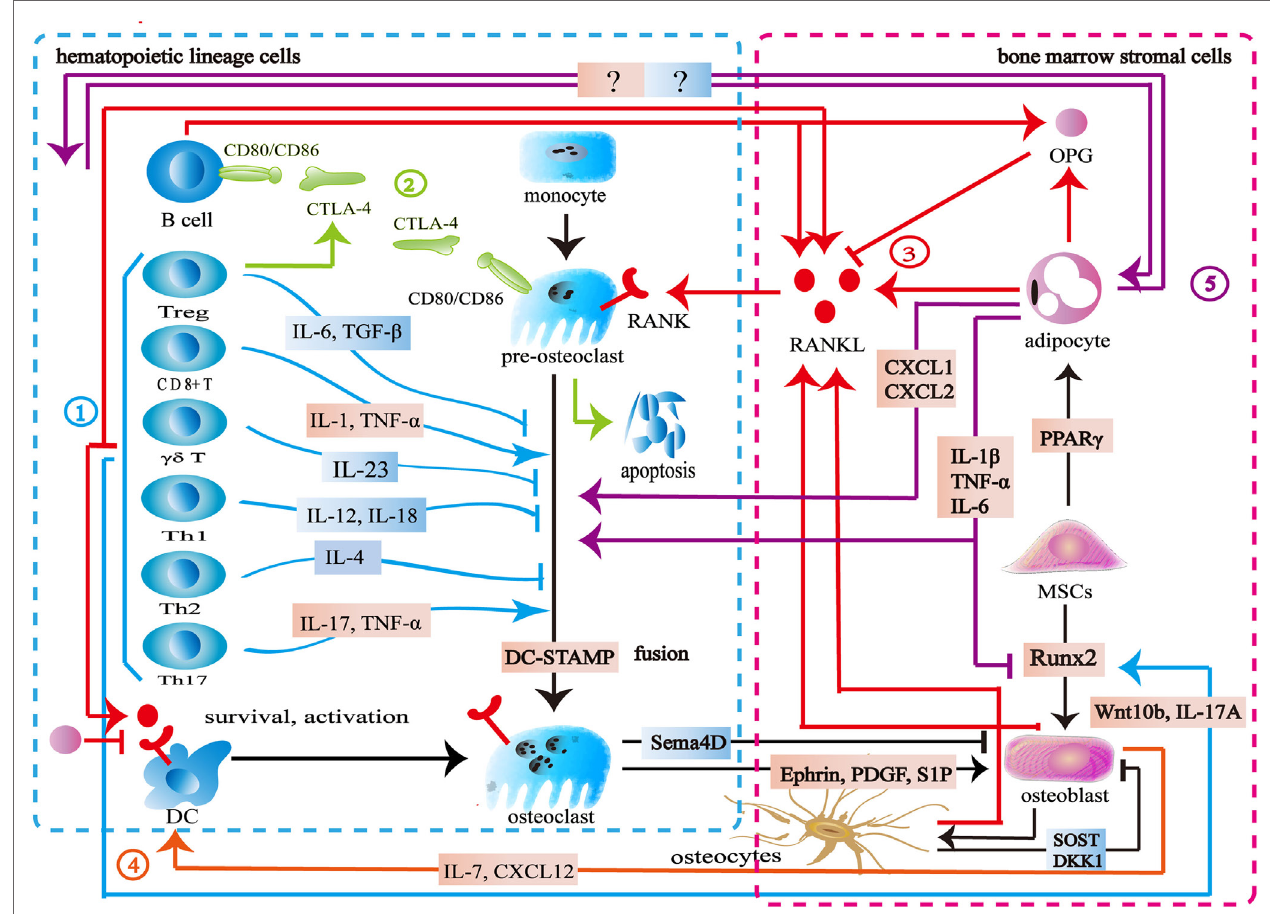
FiGURe 1 | Interaction between the skeletal and immune systems. ① The immune cells produce various cytokines and molecules to regulate bone cells. IL-23, IL-6, IL-12, IL-18, IL-4, interferon-gamma (IFN- γ ), TGF- β , and OPG inhibit osteoclastogenesis, while IL-1, IL-6, IL-17, TNF- α , TNF- β , RANKL, and macrophage colony stimulating factor promote osteoclast formation. Wnt10b, IL-17A, and BMP-2 enhance osteoblast formation. ➁ Cytotoxic T lymphocyte antigen 4 (CTLA-4) promotes the apoptosis of osteoclast precursors by binding to CD80/CD86 on the surface of osteoclasts to induce indoleamine 2,3-dioxygenase. CTLA-4 binds to CD80/CD86 on the surface of B cells to inhibit antigen presentation and the costimulatory signaling in T cells. ➂ The skeletal and immune systems share RANK– RANKL–OPG pathways. ➃ Osteoblasts produce CXCL12 and IL-7 to maintain lymphopoiesis. ➄ Bone marrow adipocytes produce several factors to regulate osteoclasts, osteoblasts, and immune cells.